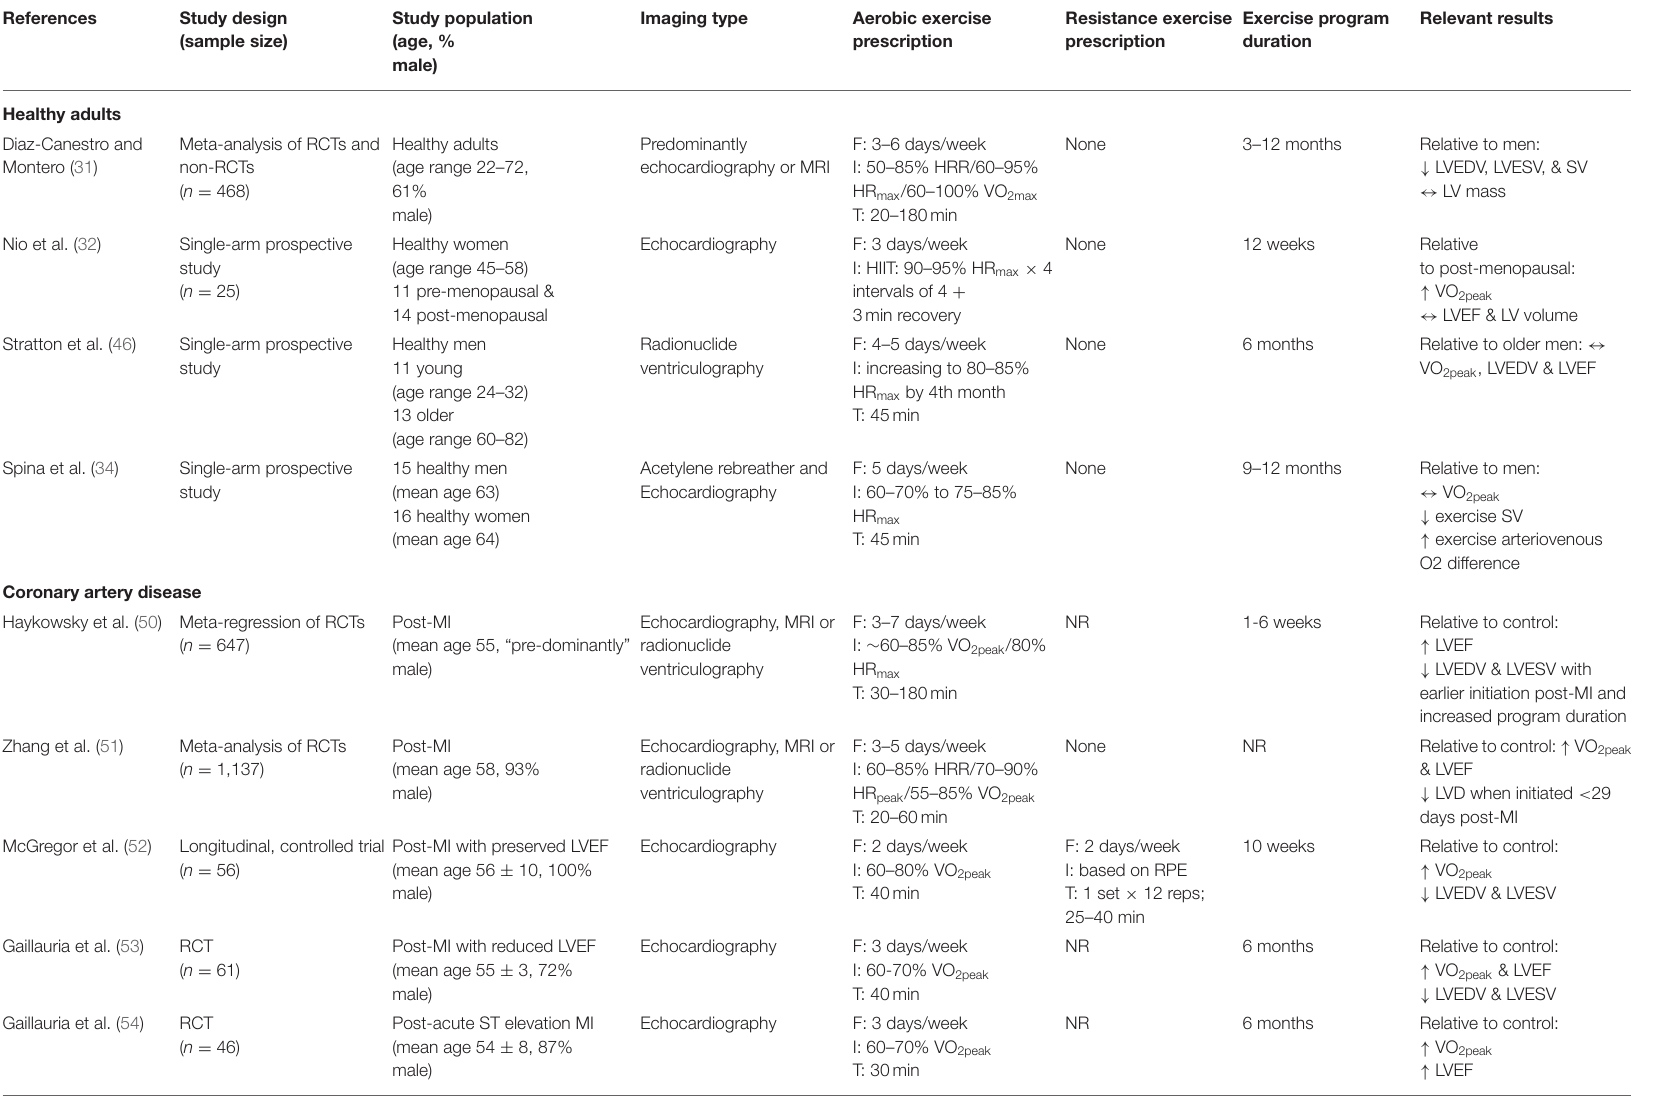
TABLE 1 | Characteristics of the imaging studies reporting on the cardiac effects of exercise